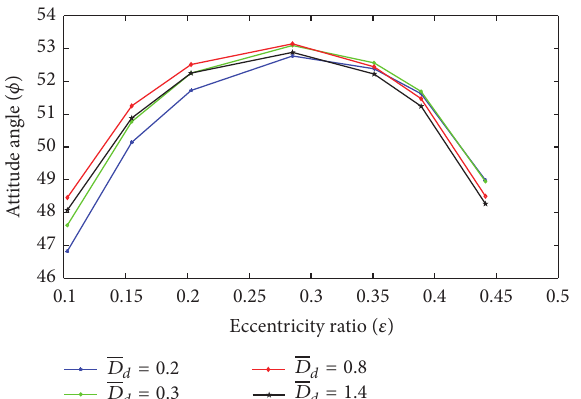
Figure 15: Effect of dam depth ratio on attitude angle.